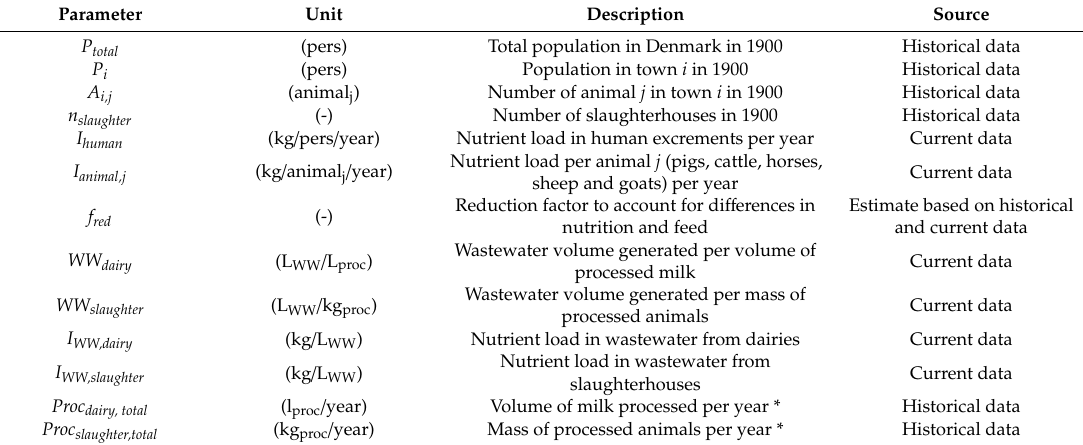
Table 1. Quantitative parameters collected for the calculation of initial nutrient loads (both nitrogen and phosphorous) from humans, animals and industries. For values and references for each parameter, please refer to the results section and Supplementary Table